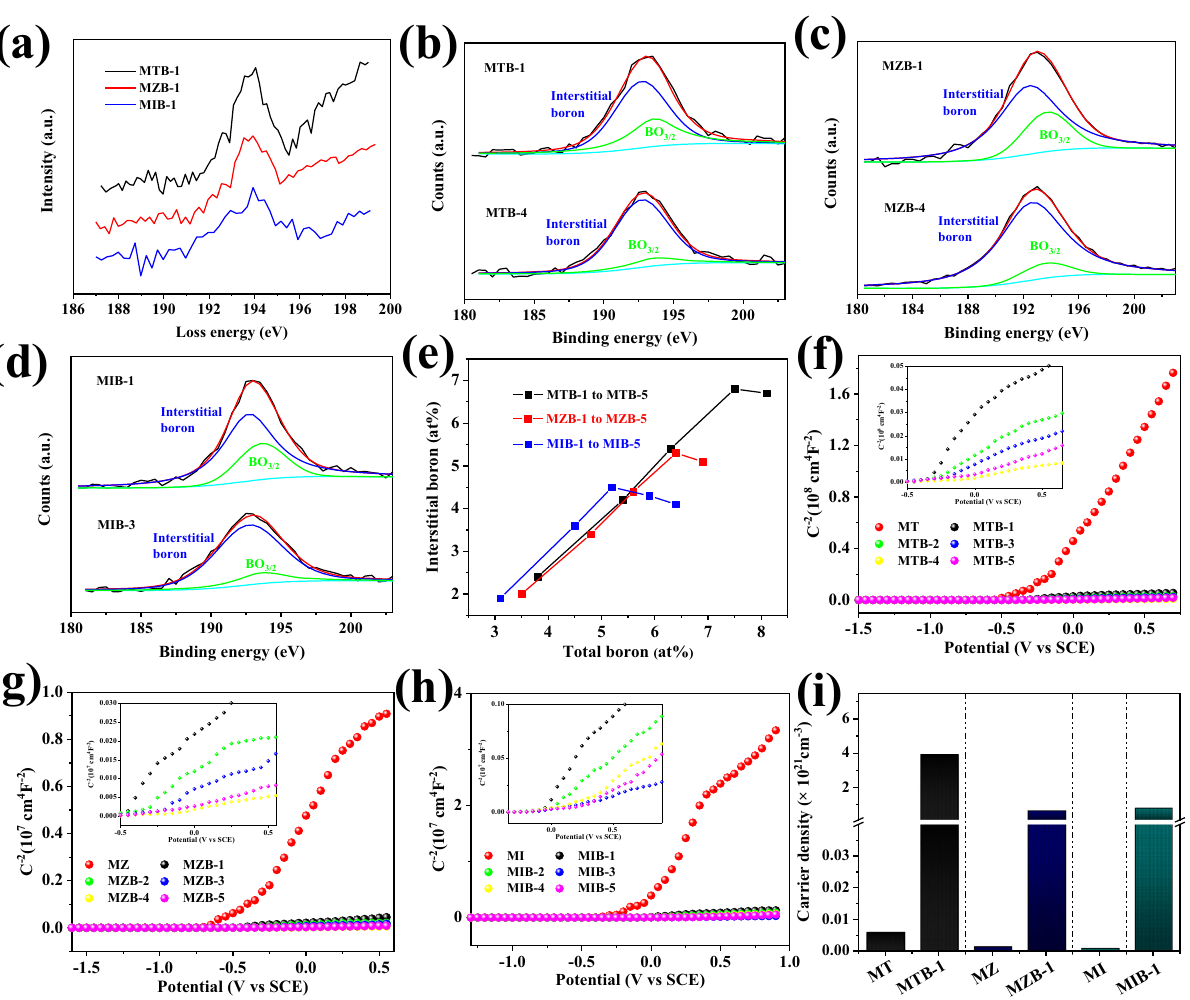
Fig. 2 Spectroscopic and electronic characterization. a Electron energy loss spectroscopy (EELS) spectra from MTB-1, MZB-1, and MIB-1. b – d High- resolution XPS spectra for B 1 s of MTB-1 and MTB-5, MZB-1 and MZB-5, and MIB-1 and MIB-5. e Interstitial boron (at%) as a function of total doped boron determined from XPS analysis in MTB-1 to MTB-5, MZB-1 to MZB-5, and MIB-1 to MIB-5. f – h Mott − Schottky plots for MTB-1 to MTB-5, MZB-1 to MZB-5, MIB-1 to MIB-5, and the undoped samples (MT, MZ, and MI). i Calculated carrier densities of MTB-1, MZB-1, MIB-1 and their corresponding pristine samples MT, MZ, and